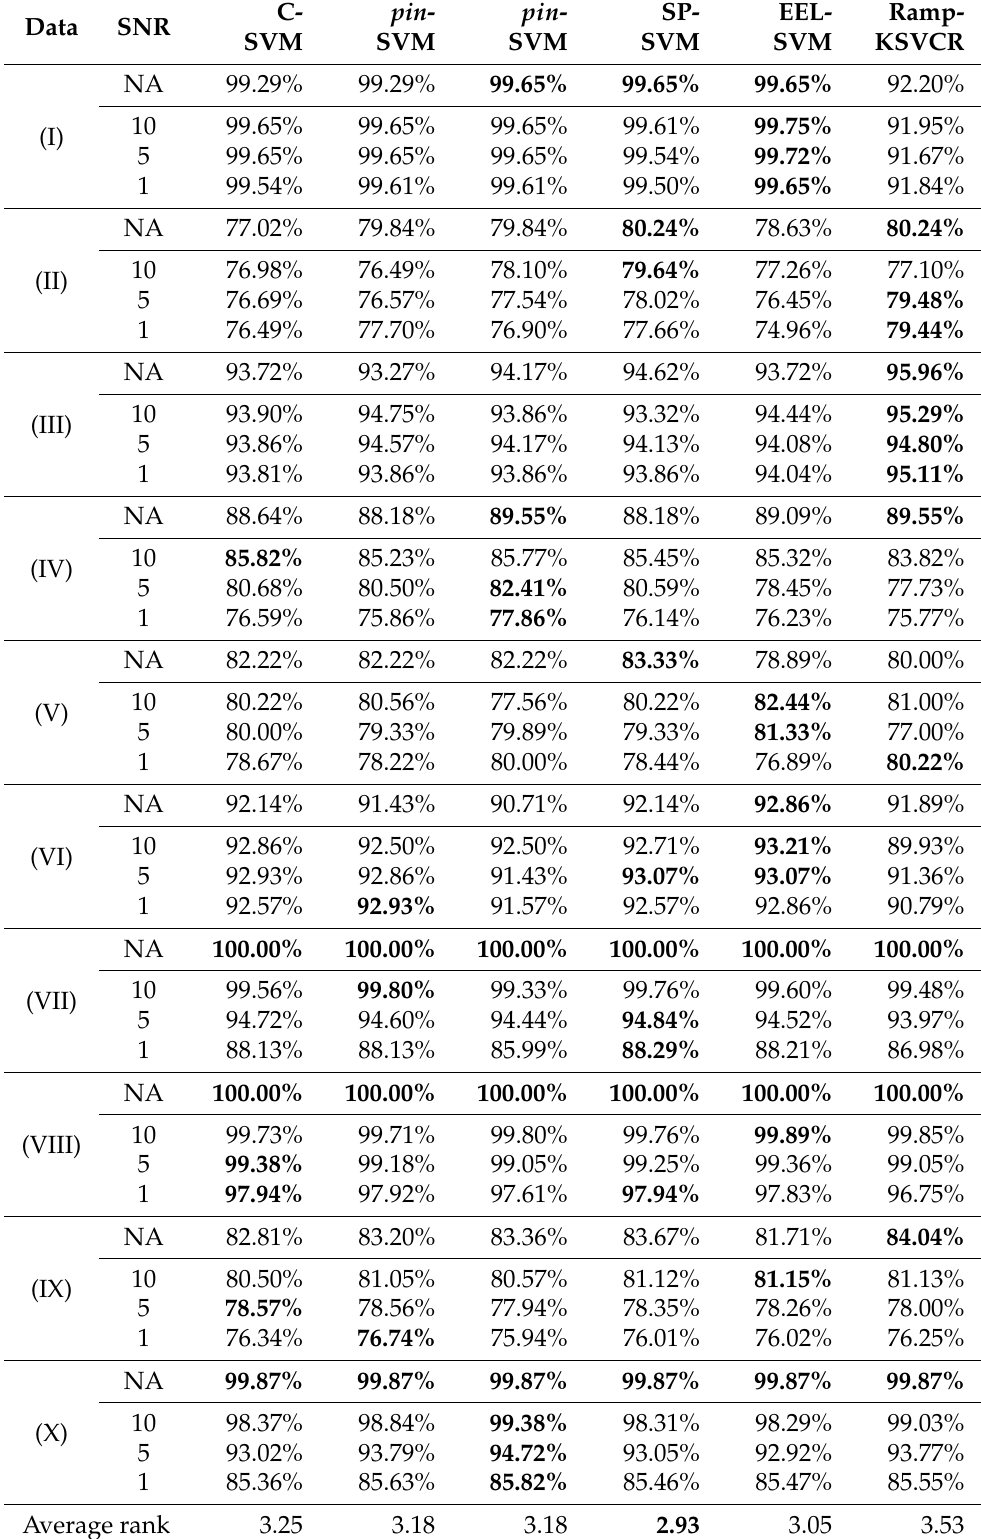
Table 5. Classification accuracy (in %) of all SVM classifiers across all datasets. Highest accuracies along each row in bold. Each row signifies the original data (reported as “NA”, i.e., no contamination) or their contaminated variants (with SNR values 1, 5,